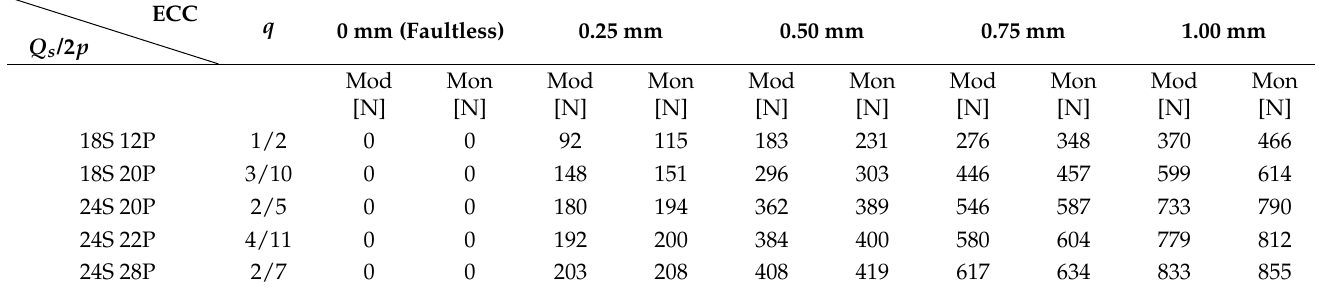
Table 7. Average UMF for different slot/pole combinations of PMSM and MPMSM in the presence of